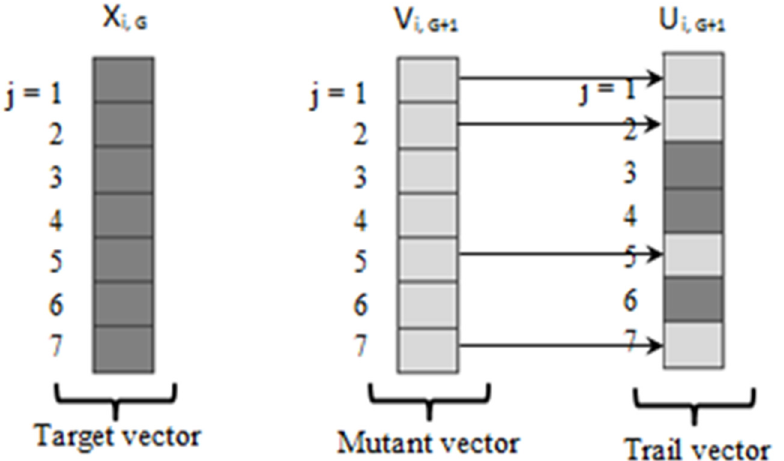
Fig 5. Illustration of Crossover Process of DE with vector dimension ( j ) of 7. Target vector is current solution with mutant vector is another possible solution. Trail vector is new solution after crossover process between target vector and mutant vector